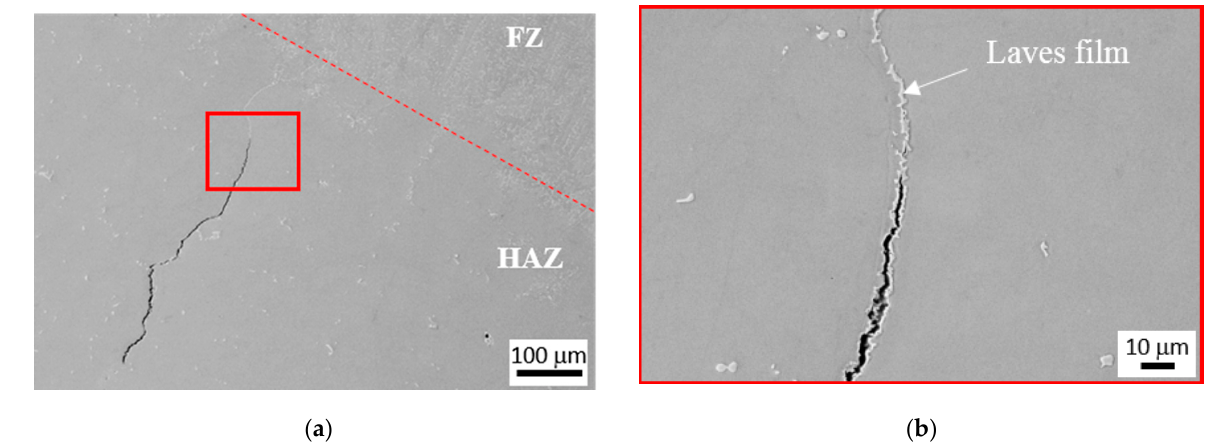
Figure 12. ( a ) Grain boundary cracking in HAZ and ( b ) higher magnification of squared zone. Mould P. Table 8. Composition of Laves phases (in wt %) at different locations in 9 mm thickness sample of Mould P.